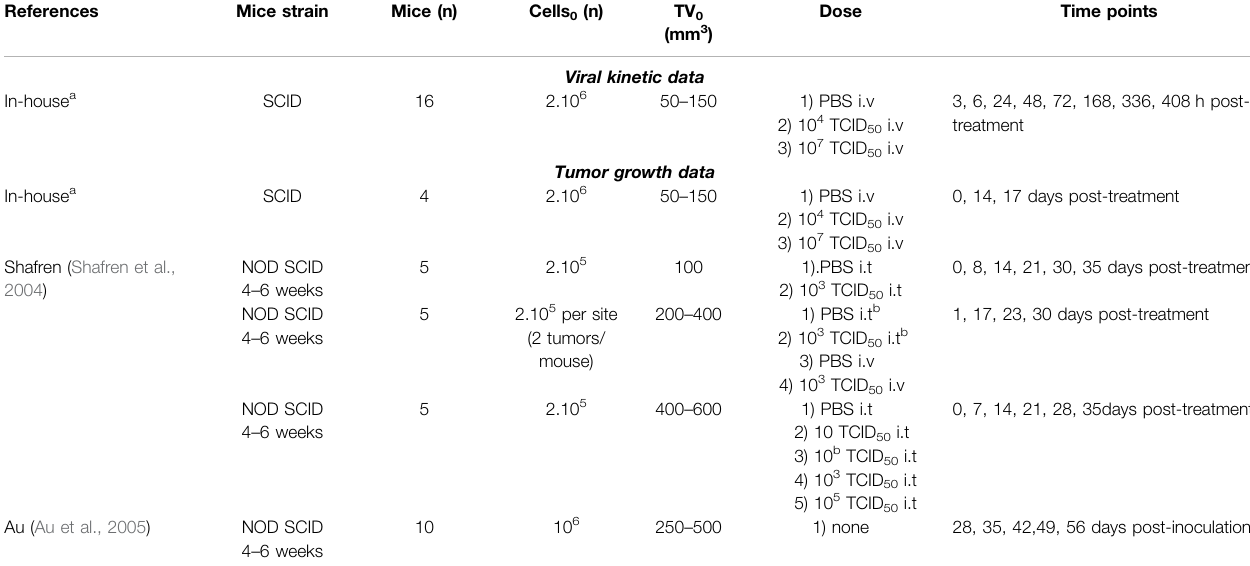
TABLE 1 | Design of in vivo